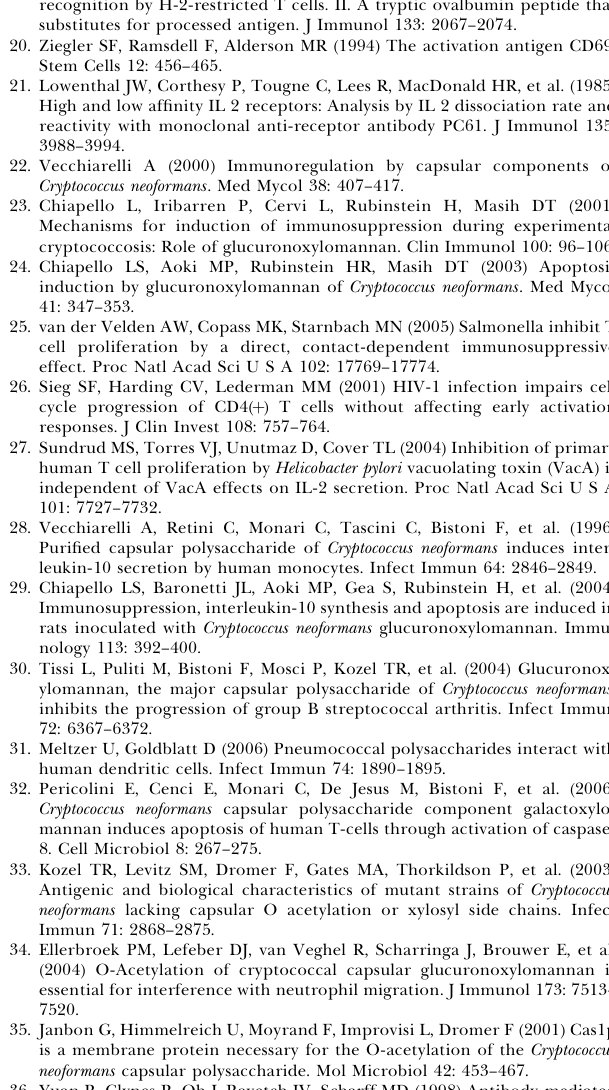
Figure S1. Effect of GXM on [ 3 H]Thymidine Incorporation by Cell Lines Murine P1D6 T cells, CTLL-2 T cells, J558L plasmacytoma B cells, and human Jurkat T cells were incubated in the presence or absence of GXM (300 l g/ml) for 24 h, and proliferation was measured by [ 3 H]thymidine incorporation. Data are expressed as the mean 6